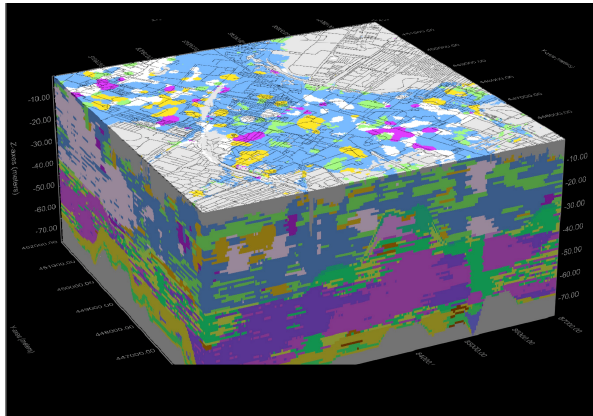
Figure 1. 3-D Geological model on a scale of 100 × 100 × 0.5 ( L × W × H ) based on all available boreholes and CPTs. Colors indicate variation in lithology and are user-defined. The picture in- dicates the heterogeneity of the subsoil (pink = peat, green and blue are different clays, yellow are Holocene